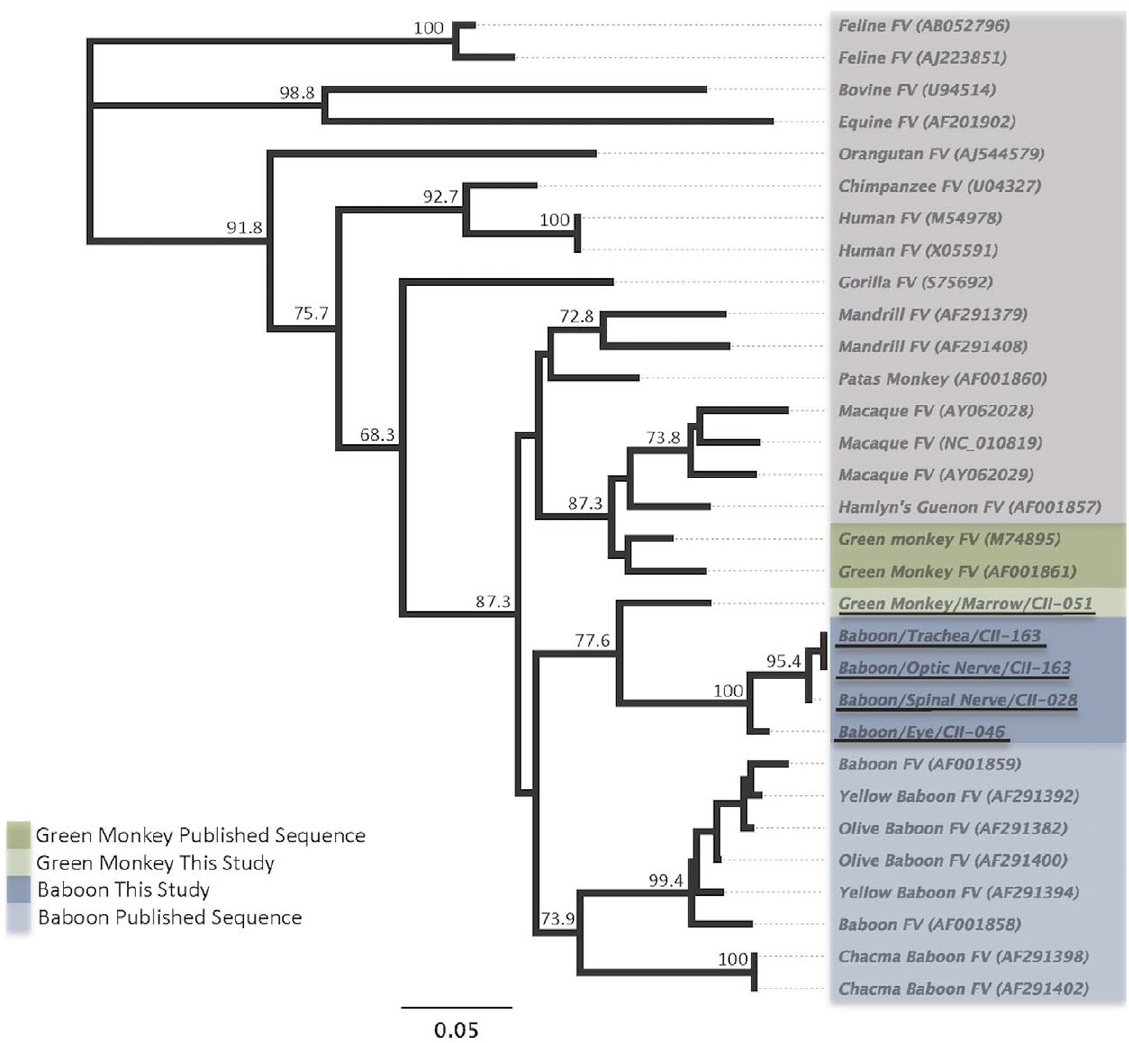
Figure 3. Inferred phylogenetic relationships of SFV pol ( , 153 bp) sequences detected in USFWS bushmeat samples. Neighbor- joining (NJ) and maximum-likelihood (ML) analysis gave identical branching orders. New SFV sequences identified in this study are underlined.